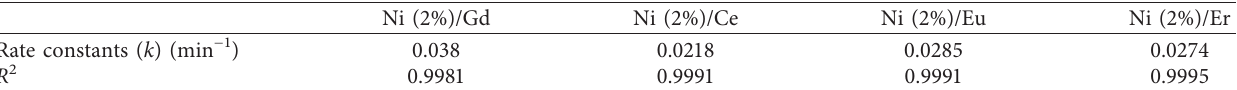
Table 10: Kinetic parameters of 100 mg · L − 1 RhB in electrochemical processes by Ti/SnO modified with Ni (2%)